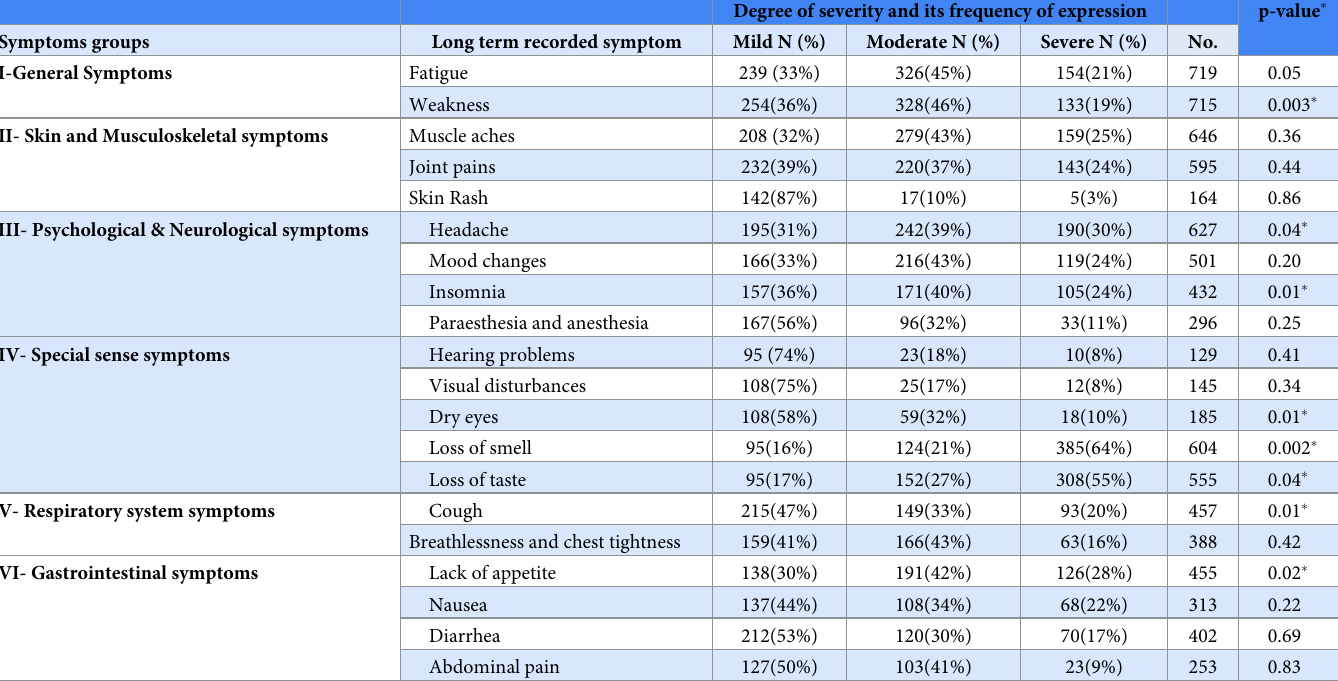
Table 3. Degree of severity of the recorded post recovery COVD-19 long-term symptoms with their frequency of expression.